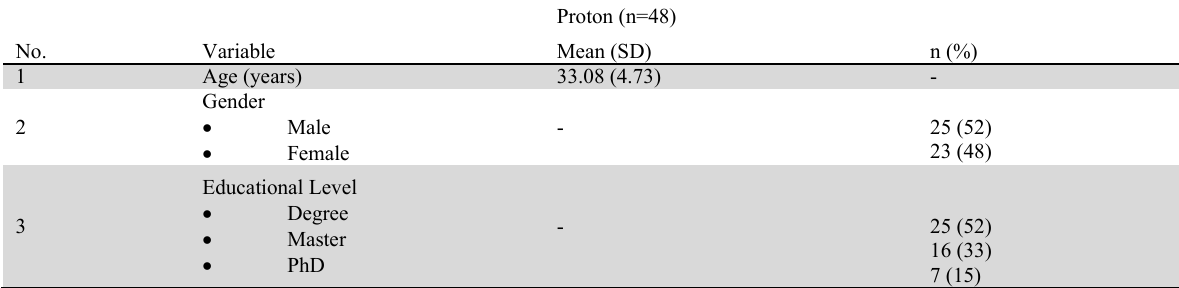
Respondent Profile